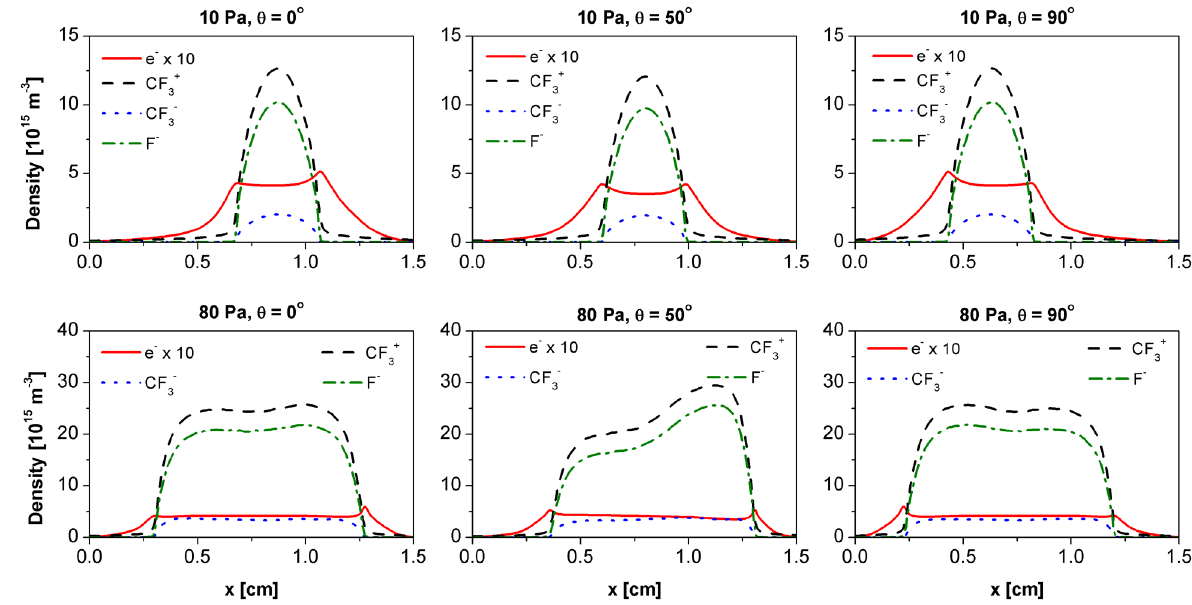
Figure 10 : Time averaged charged particle densities in electrically asymmetric dual-frequency discharges operated at 13.56 MHz + 27.12 MHz for different values of the phase shift between the driving harmonics, θ, at 10 Pa, Φ Φ =Φ = 50 V (second row). The color scales are given in 10 3 Vm -1 and apply to all plots in the same row. LF HF